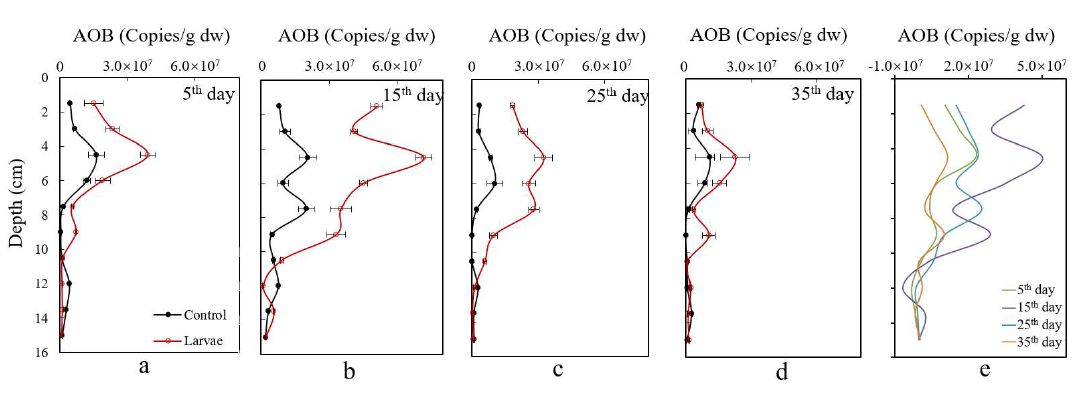
Figure 6. Ammonia-oxidizing bacteria (AOB) profiles in sediments of the control and the Chironomid larvae treatment. Dw: dry sediment. (e) AOB abundance changes in treatment minus changes in control on the 5th ( a ), 15th ( b ), 25th ( c ) and 35th ( d ) day, respectively.